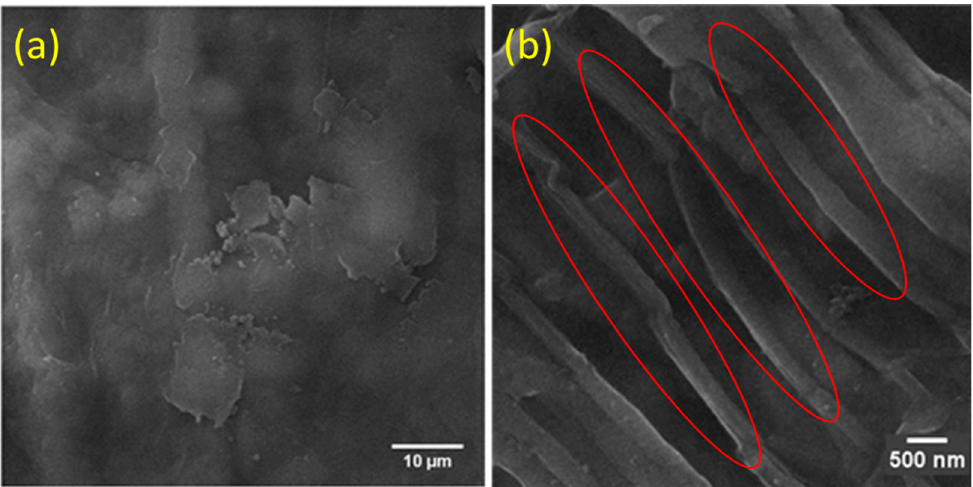
Figure 2. SEM images of the GNF before ( a ) and after ( b ) homogenization. (The formation of the GNF is marked in red).